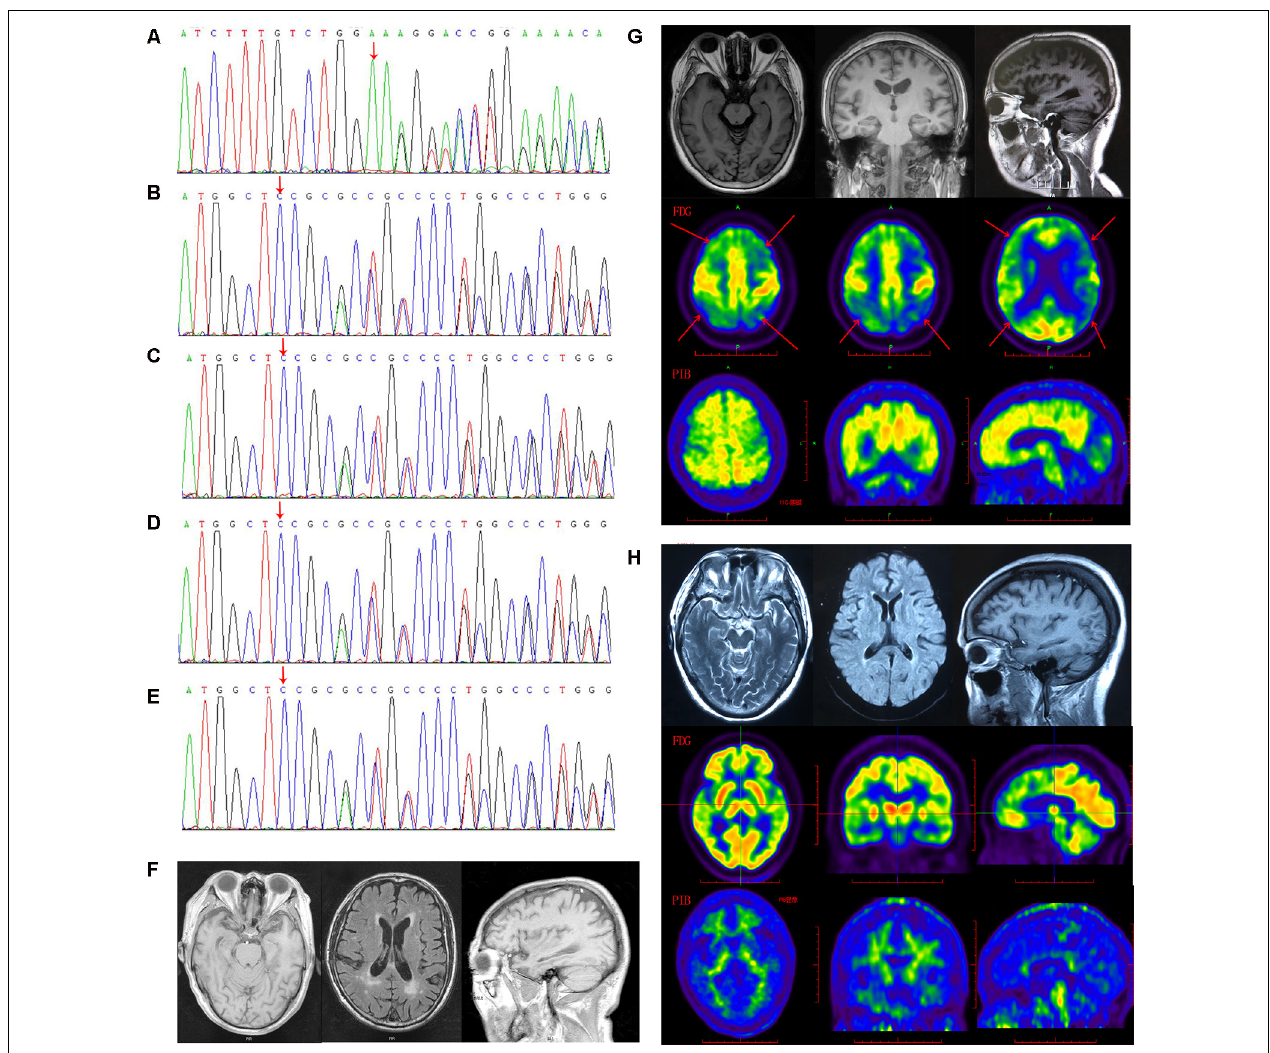
FIGURE 1 | The gelsolin ( GSN ) gene mutation sequencing diagram and patients’ imaging. (A) The sequencing diagram of case 1 (GSN:c.1036delA:p.K346). (B) The sequencing diagram of case 2 (GSN:c.8_35del:p.P3fs). (C) The sequencing diagram of case 3 (GSN:c.8_35del:p.P3fs). (D) The sequencing diagram of case 4 (GSN:c.8_35del:p.P3fs). (E) The sequencing diagram of case 5 (GSN:c.8_35del:p.P3fs). (F) The magnetic resonance imaging (MRI) of case 4 with P3fs mutation. (G) The MRI, FDG-PET and PIB-PET of case 1 with K346fs mutation. (H) The MRI, FDG-PET and PIB-PET of case 5 with P3fs mutation).